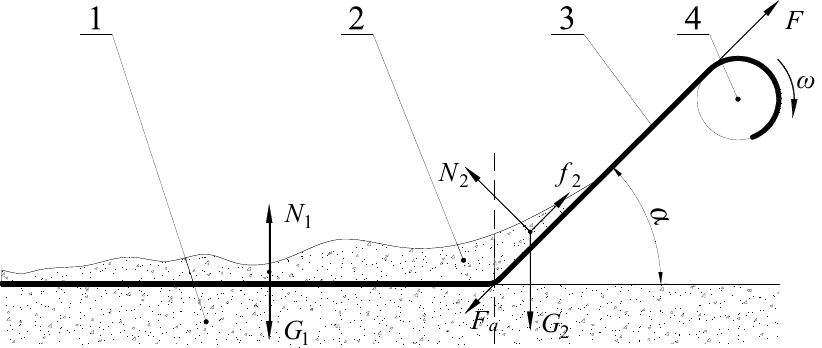
Figure 5. Diagram of force between plastic film and soil under the action of curl ‐ up force: 1—soil under the film, 2—soil on the film, 3—film, 4—film ‐ curling mechanism.